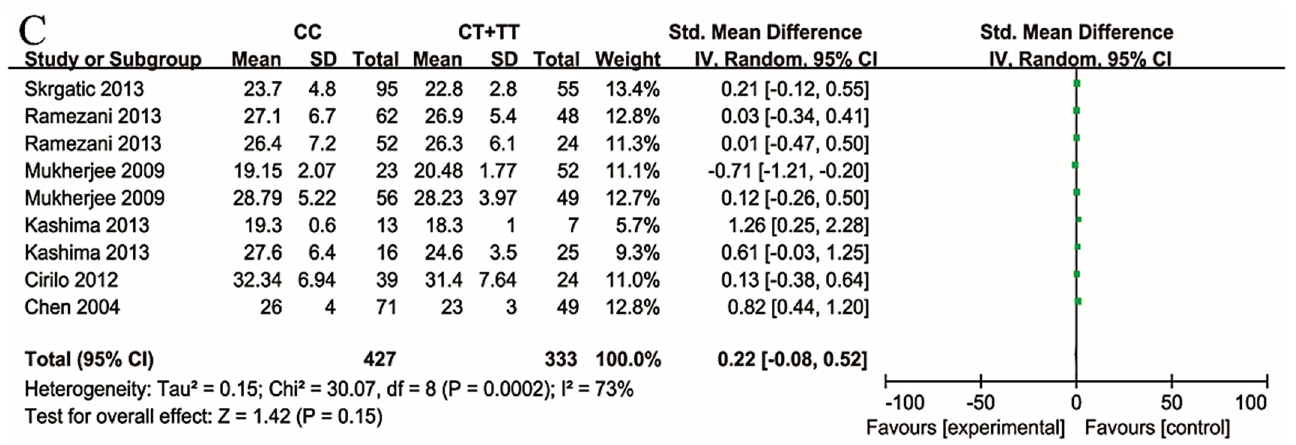
Figure 4. Forest plots of association between genotype frequencies of SNP rs1799817 and PCOS risk. ( A ) Stratified by ethnicity; ( B ) stratified by BMI; ( C ) pooled standardized mean differences of BMI in PCOS patients with different